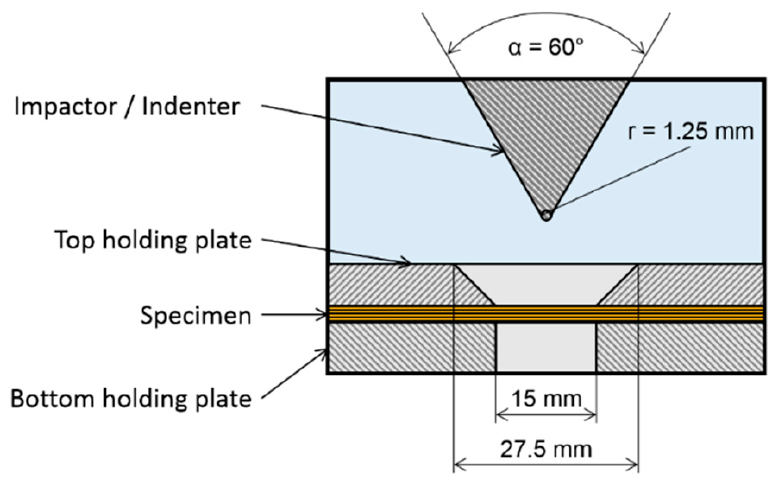
Figure 1. Indentation tests: specimen’s clamping system and indenter.